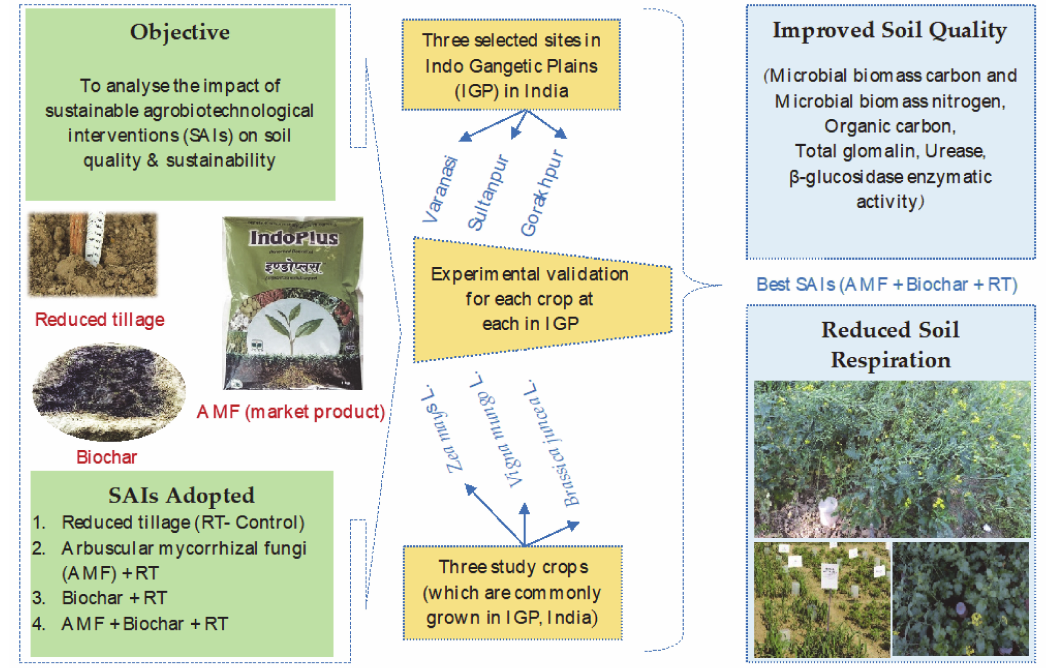
Figure 4. Flowchart of overall practices employed for three different crops grown at three different sites of the Indo-Gangetic Plain, North India as well as the effects of sustainable agrobiotechnological interventions on soil quality and